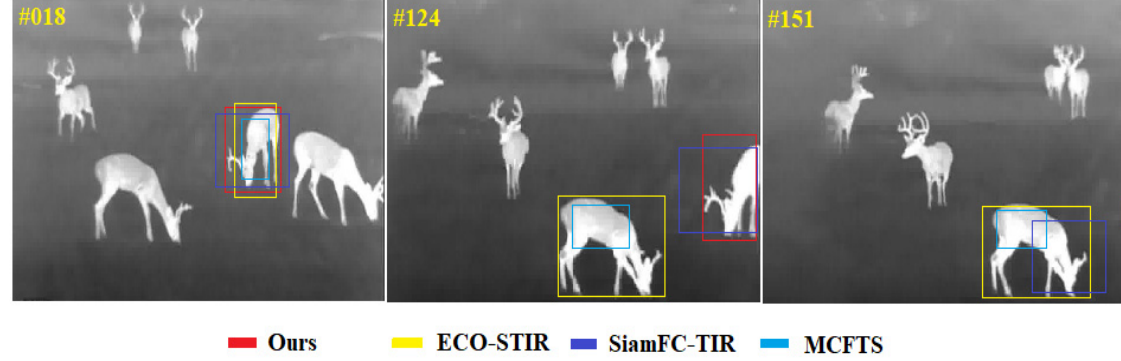
Figure 16. The visualization of tracking results in the sequence deer_H_001.